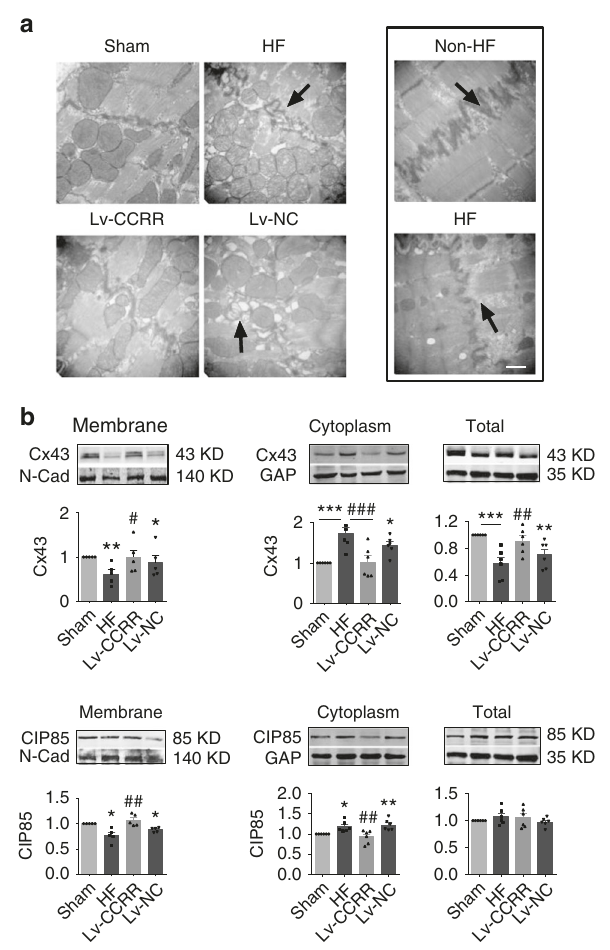
Fig. 3 CCRR alleviates destruction of intercalated discs and gap junction in HF mice. a Typical examples of electron microscopic images (30,000× magni fi cation) showing the deranged intercalated discs in HF mice (left panels) and patients (right panels), and the effects of CCRR overexpression by Lv-CCRR on the microstructure of left ventricular cardiac muscles in HF mice. Marked disruption of intercalated discs and gap junction was consistently observed in HF myocardium (indicated by arrows), and such derangement was ameliorated and restored to normal conditions after pretreatment with Lv-CCRR, but not with Lv-NC. Similar observations were repeated in another three HF mice. b Effects of CCRR overexpression by Lv- CCRR on the protein levels of connexin43 (Cx43) and CIP85 (the Cx43- interacting protein that regulates the endocytic traf fi cking of Cx43 for degradation) in HF mice. Upper panel: examples of Western blot bands; lower panel: averaged data on Cx43 and CIP85 protein levels. Comparisons of Cx43 and CIP85 at the protein levels were made between the membrane and cytoplasm fractions. Cx43 level was markedly decreased in the membrane, but increased in the cytoplasm, which resulted in an overall reduction of total protein level, indicating the enhanced endocytic traf fi cking of Cx43 in HF mice compared to the Sham-operated control animals. The membrane bands were normalized to N-cadherin (N-Cad), and the cytosolic and total protein bands were normalized to GAPDH (GAP). * P < 0.05, ** P < 0.01, *** P < 0.001; # P < 0.05, ## P < 0.01, ### P < 0.001 Lv-CCRR vs. HF; n = 5 heart samples of membrane fraction for each group, n = 6 for cytoplasmic fraction, and n = 6 for total protein. Similar changes were observed with CIP85, but its total protein level remained unaffected. * P < 0.05, ** P < 0.01; ## P < 0.01, Lv-CCRR vs. HF; n = 5 heart samples of membrane fraction for each group, n = 6 for cytoplasmic fraction, and n = 6 for total